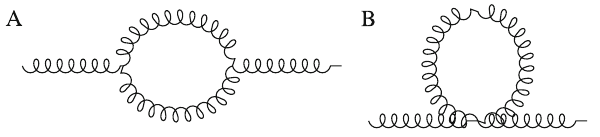
Fig. 2 One-loop self-energy Feynman diagrams of the gluon propaga- tor, Π im and Π im A B